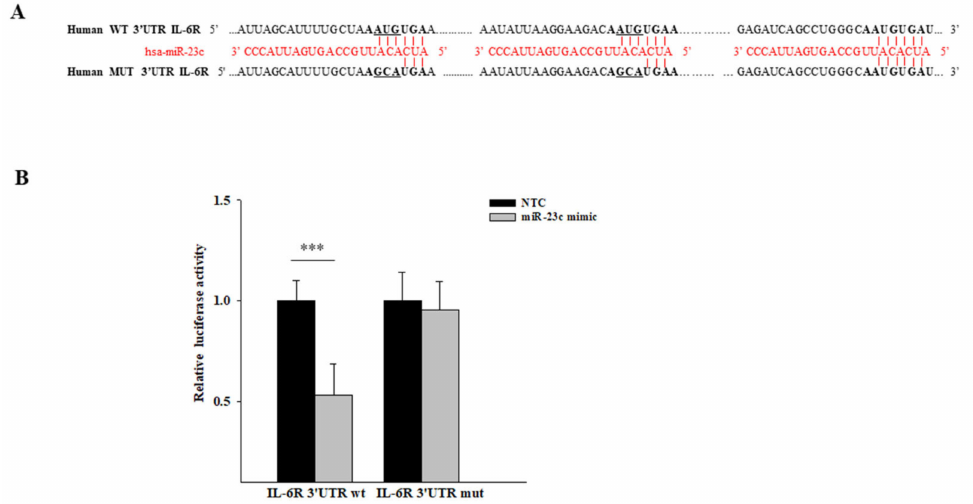
Figure 6. IL-6R is a target of miR-23c. ( A ) The putative 3 (cid:48) binding sites of miR-23c in the IL-6R mRNA are displayed. Mutated bases in the 3 (cid:48) -UTR are underlined. ( B ) A dual luciferase reporter assay was performed to validate the interaction between miR-23c and IL-6R in MDA-MB-468 transfected with miR-23c mimic or non-targeting control (NTC) (*** p ≤ 0.001; Student’s t